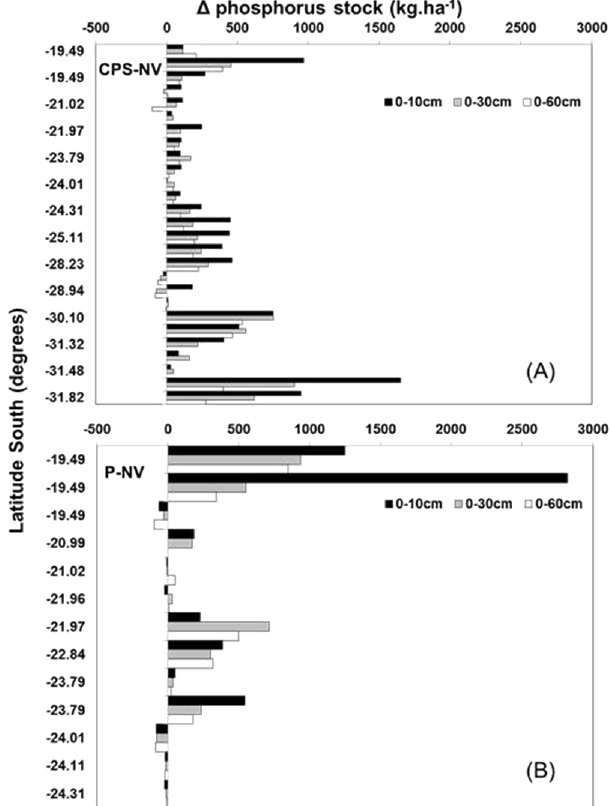
Figure 7. Absolute difference of soil phosphorus stocks between different depth intervals: (a) crop–livestock systems (CPS) and na- tive vegetation (NV) and (b) pasture ( P ) and native vegetation (NV) at different paired study sites. Each paired-site study area is indi- cated by its latitude. Losses are indicated by a minus sign ( −